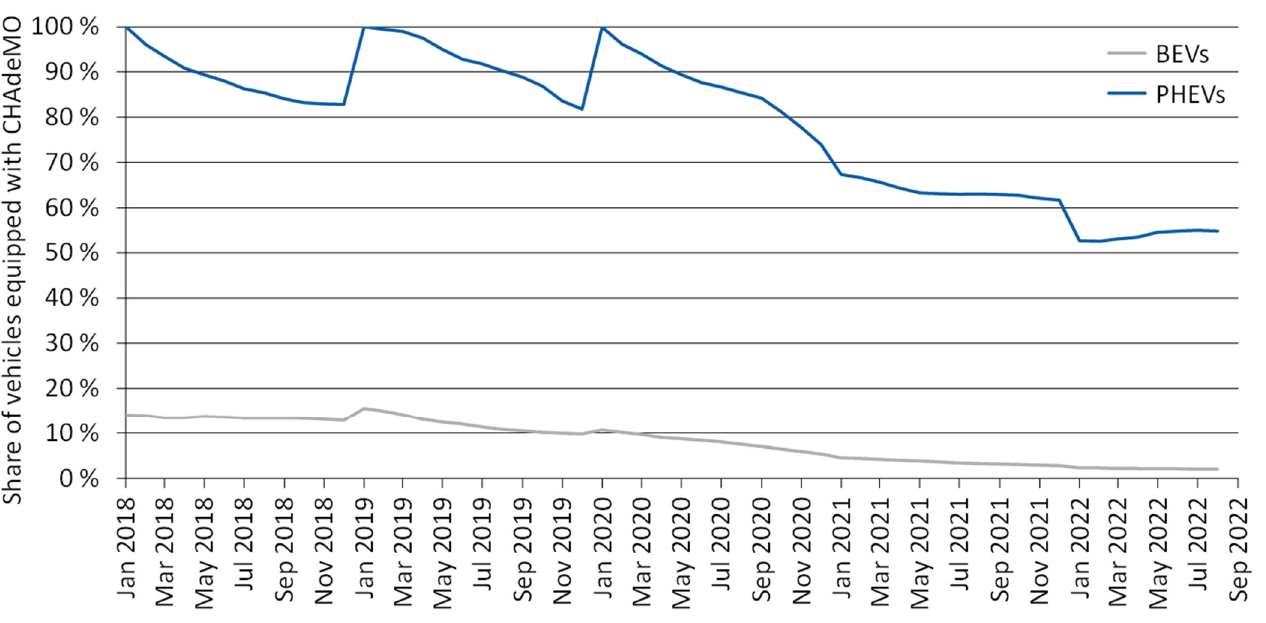
Figure 5. Number of BEVs equipped with DC fast chargers. The category “CCS or Tesla Supercharger” is comprised of vehicles for which the underlying data did not allow us to deduce which of the two these were, as Tesla has switched to the CCS for some models, and also uses the CCS as the only standard on V3 superchargers in Europe.